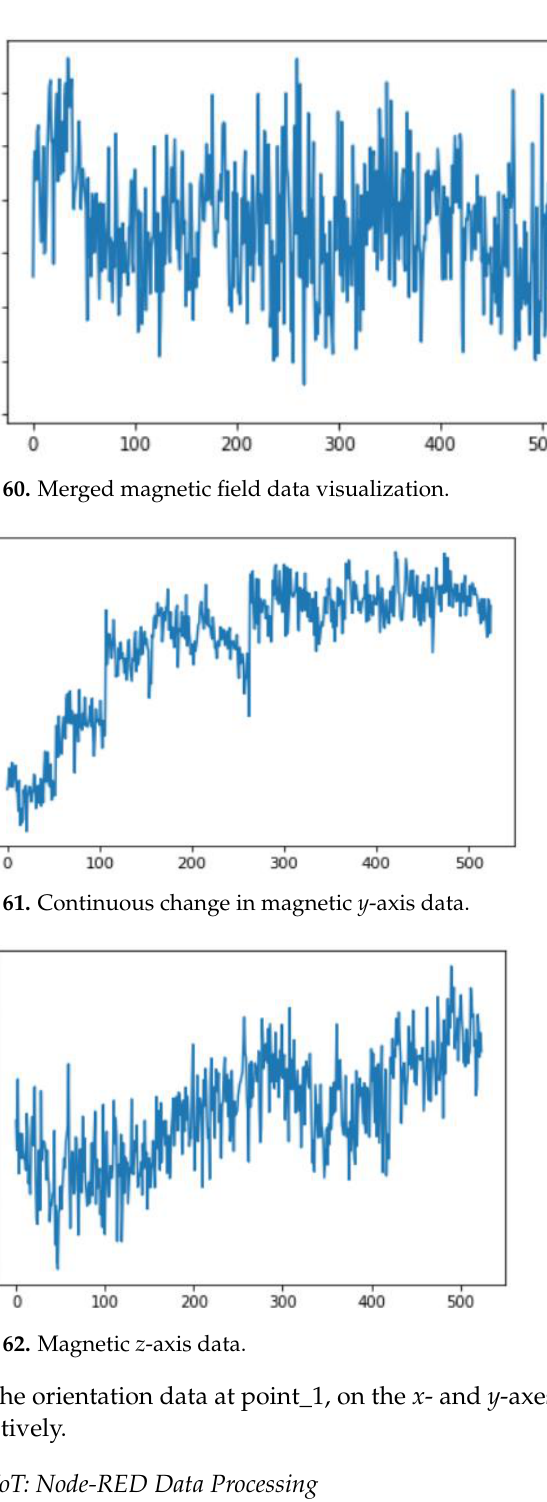
Figure 62. Magnetic z -axis data.